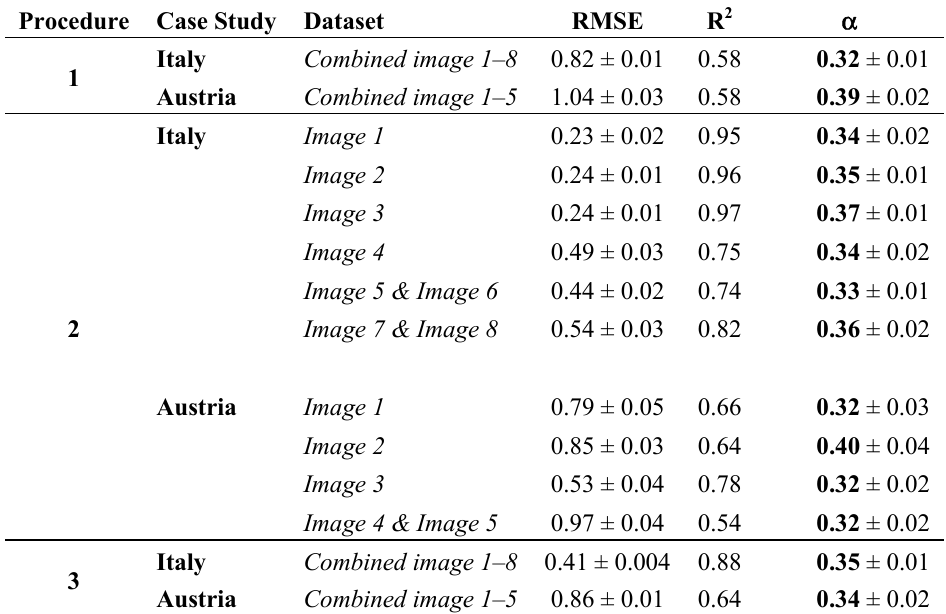
Table 4. Statistics of the CLAIR model accuracy based on the experimental field